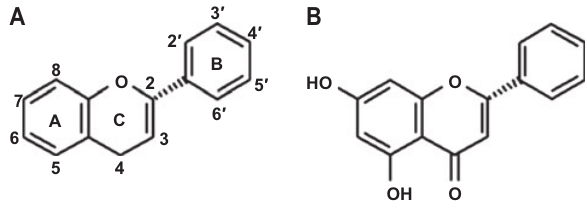
Figure 1 Chemical structures of fl avonoids: (A) general structure, (B)